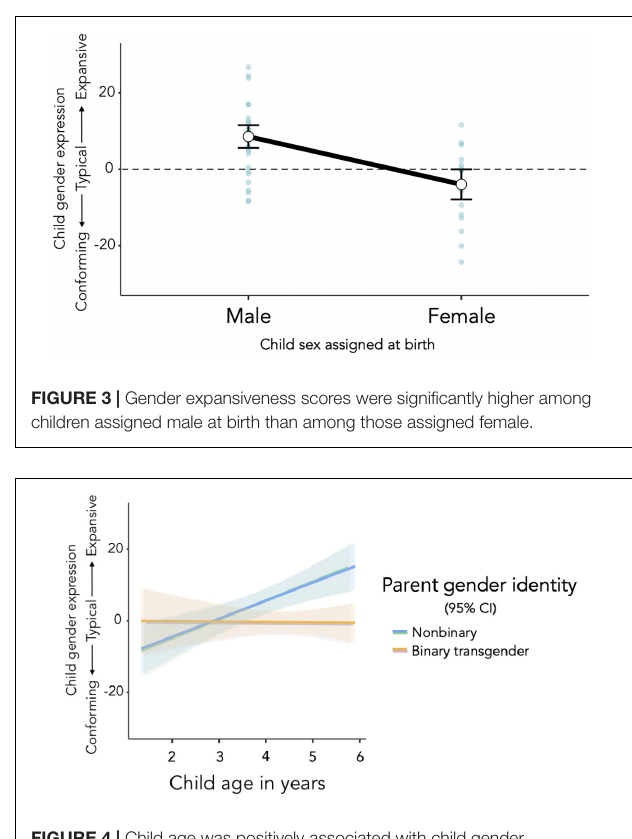
FIGURE 4 | Child age was positively associated with child gender expansiveness among children with nonbinary parents, but these variables were not associated among children with binary transgender